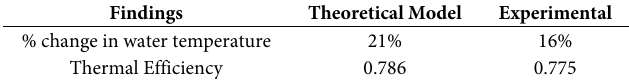
Table 5. Comparison of Experimental and Theoretical Results